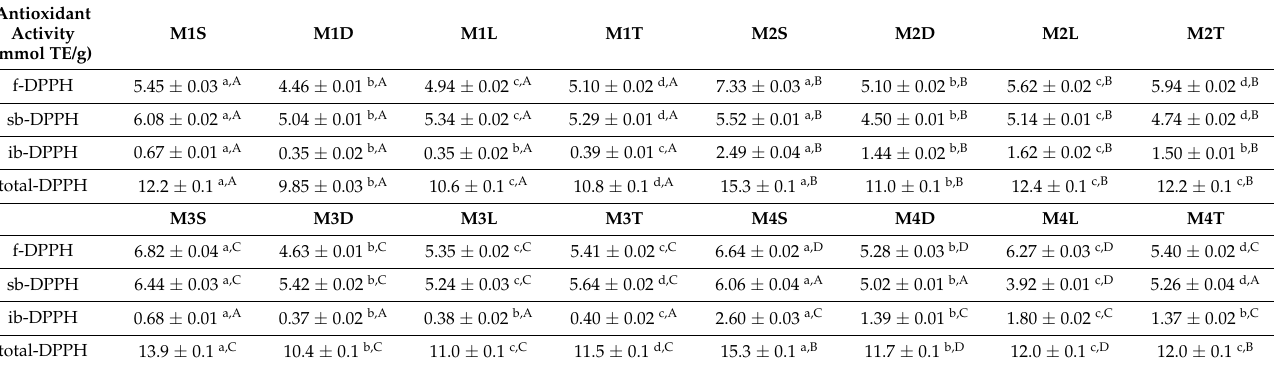
Table 6. Antioxidant activity values of nutraceutical mixtures under the defined storage conditions measured using DPPH